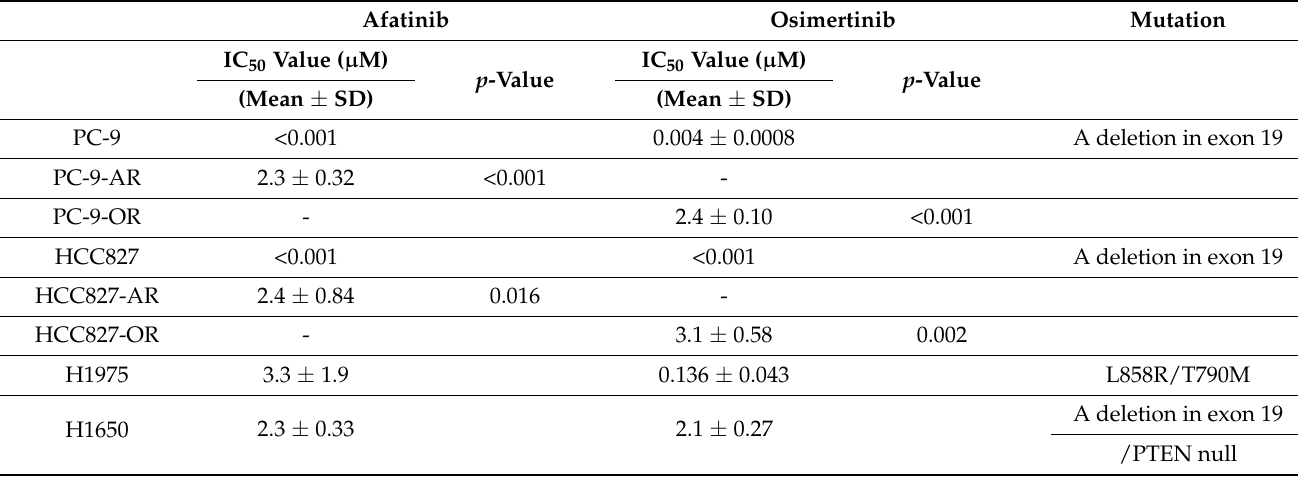
Table 1. Characteristics and IC 50 of parental and established EGFR-TKI-resistant NSCLC